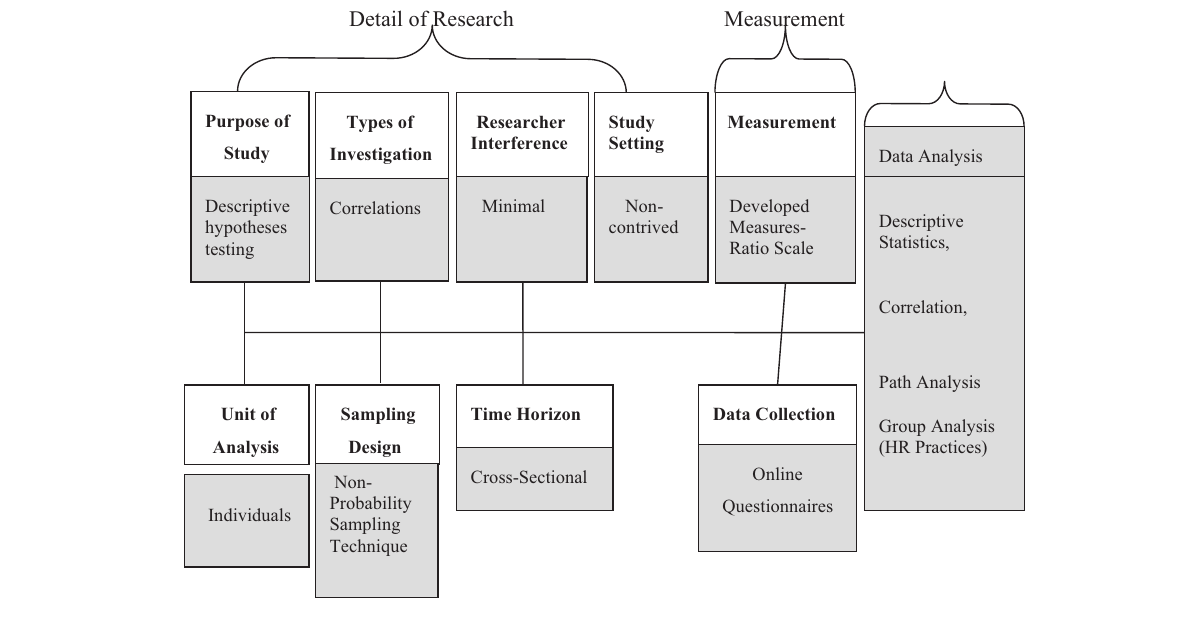
FIGURE 2 | Research design flow